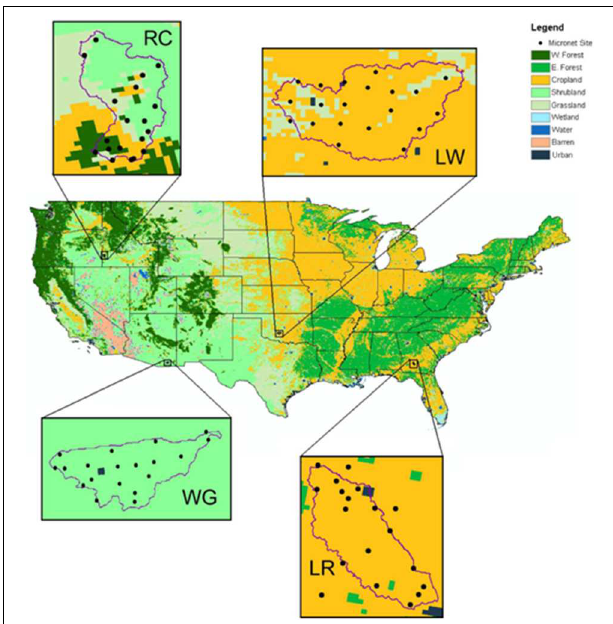
FIGURE 3 | Geographyc location of the ARS watersheds. As illustrated by the image, the four watersheds provide a large variety of vegetation conditions and climate